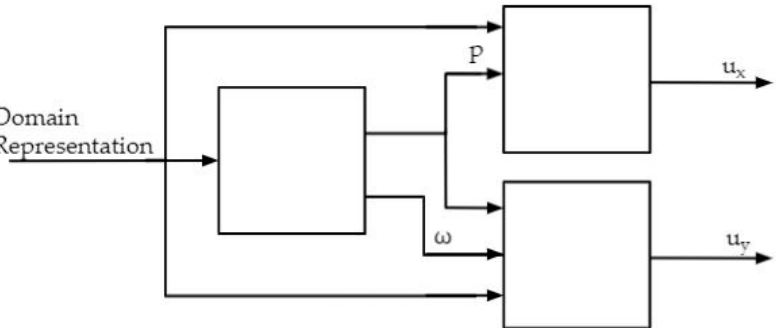
Figure 10. ANN structure to test the proposed network under different conditions.